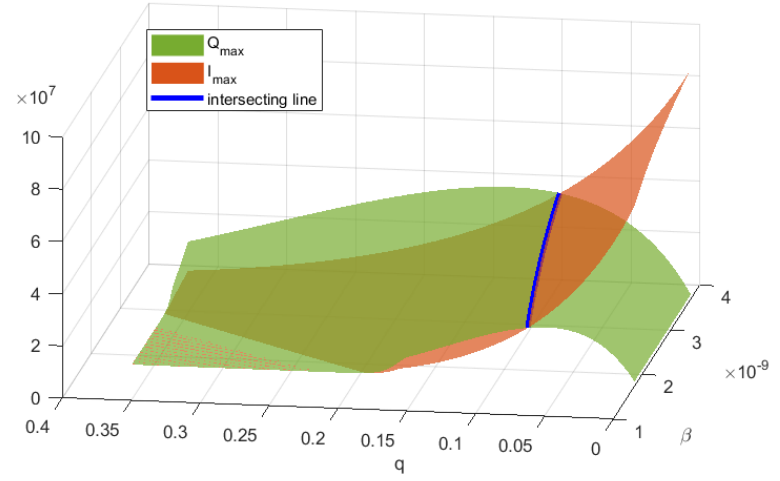
Figure 7. Comparison between Q max and I max for different values of β and q